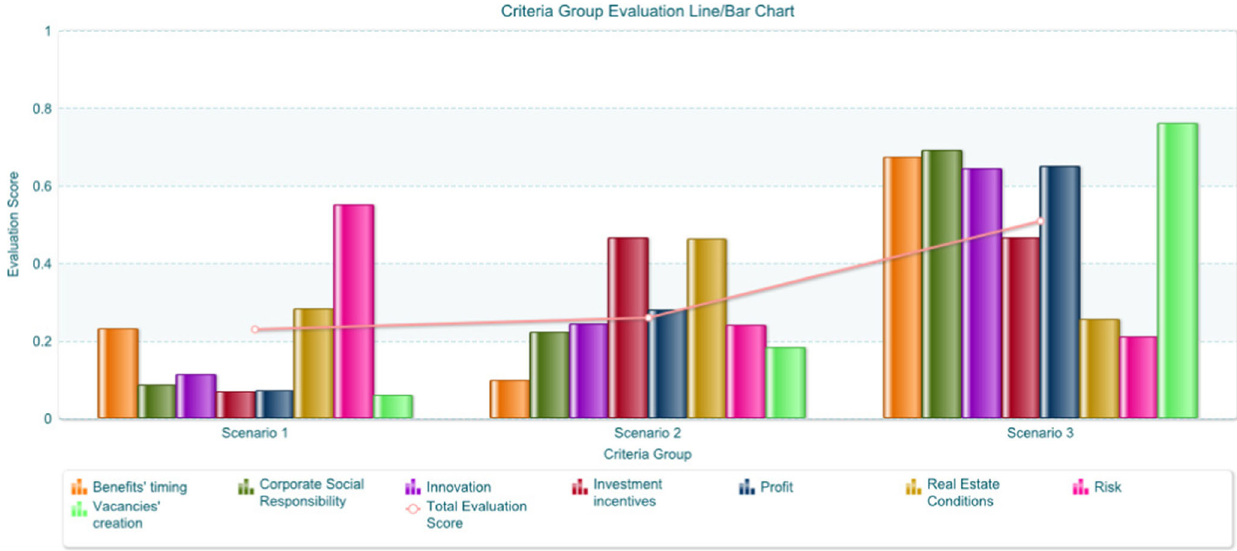
Fig. 9 Criteria Group D Evaluation Line/Bar Chart (MAMCA Software, own setup)